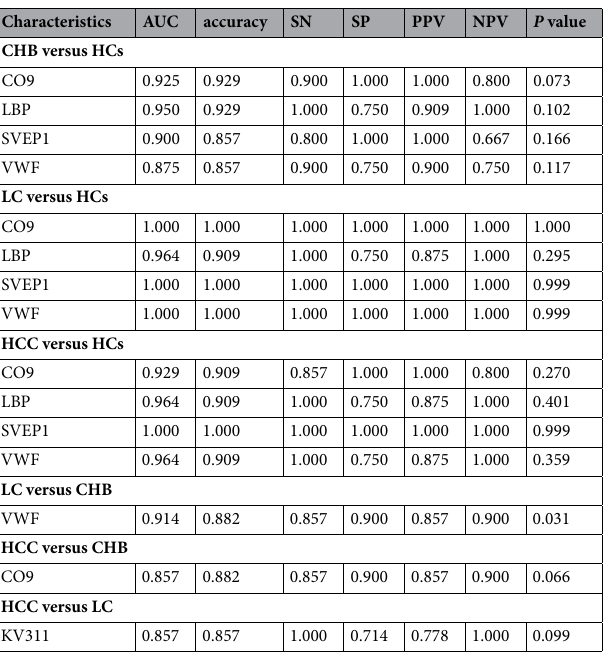
Table 1. The diagnostic capacity of the selected liquid biopsy biomarkers from serum extracellular vesicles (sEVs). AUC Area under the receiver operating characteristic curve, CHB Chronic hepatitis B, HCs Healthy controls, HCC Hepatocellular carcinoma, LC Liver cirrhosis, SN Sensitivity, SP Specificity, PPV Positive predictive value, NPV Negative predictive value.